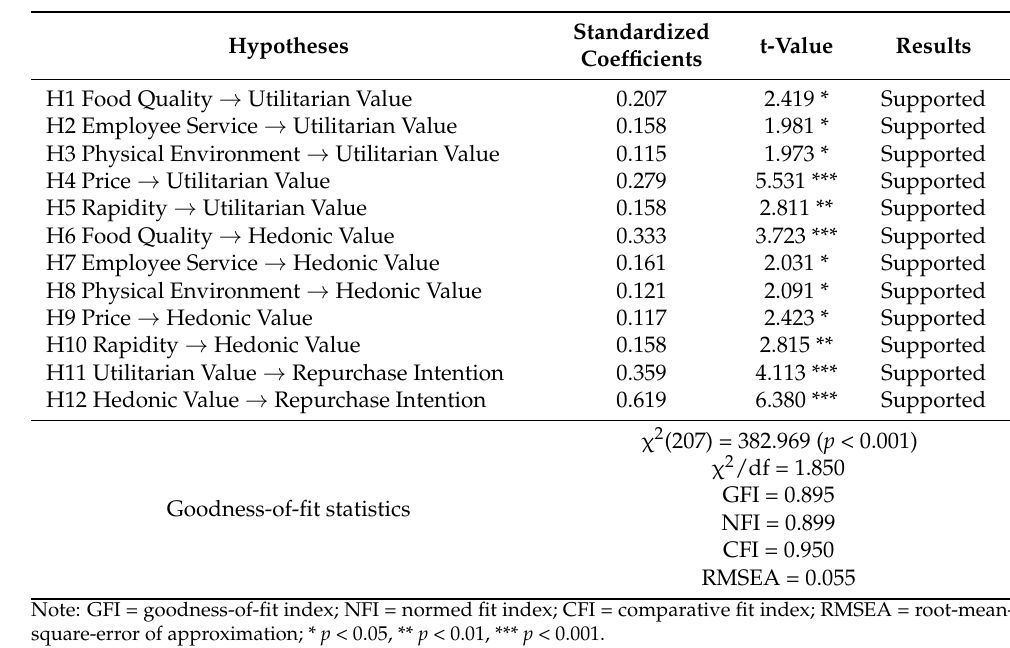
Table 4. Structural parameter estimates.